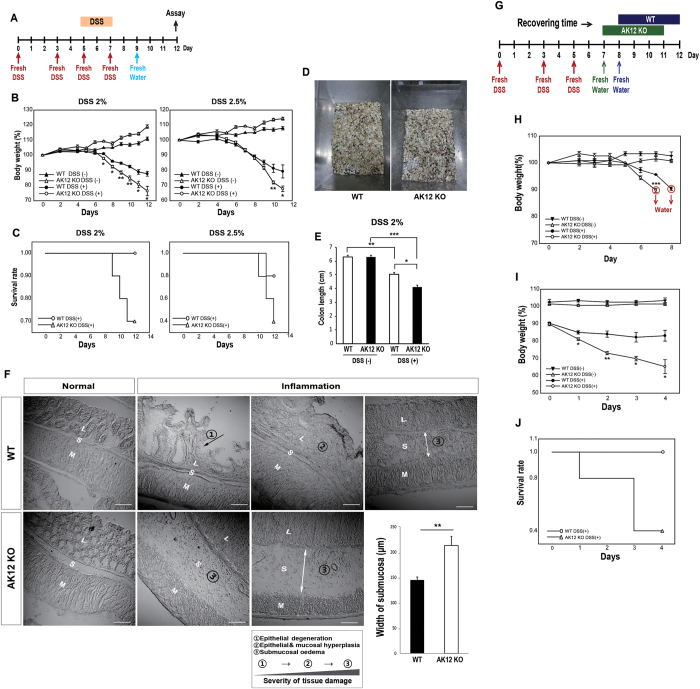
Protective role of AKAP12 during intestinal inflammation recovery.(A–F) WT and AKAP12 KO mice were given 2 or 2.5% DSS in their drinking water with control group (normal water) for 8 days and were then allowed to recover with normal drinking water for a further 4 days (n = 10 per group for DSS 2%, n = 5 per group for DSS 2.5% and n = 5 per group for controls). (A) Schedule of DSS ingestion to WT and AKAP12 KO mice. (B) Percentage of body weigh changes in WT and AKAP12 KO mice after given 2 or 2.5% DSS in water. (C) Proportion of survived mouse to total mouse in each groups were recorded at each days. (D) Picture of blood stools in cage of DSS induced WT and AKAP12 KO mice were taken. (E) Colon lengths were recorded by using ruler on day 12 (n = 5 or 4 for WT or AKAP12KO, respectively). (F) Tissue states were marked in images and numbered with order of tissue damage. Width of submucosa in image was measured by ruler and then the value was converted to real value by using scale (n = 5 per group). Bars: 100 μm. (G–J) WT and AKAP12 KO mice were given normal water for further 4 days after given 2% DSS until body weight of each group decreased to 90% compared to initial body weight or after given normal water (n = 5 per group for DSS 2% and n = 5 per group for controls). (G) Schedule for comparing the recovering ability of WT and AKAP12 KO mice directly. AKAP12 KO mice were given 2% DSS for 7 days and WT mice for 8 days and then, changed DSS water to normal water. (H) Body weights of WT and AKAP12 KO were decreased to 90% at 8 day and 7 day, respectively (red circle). (I) Body weight changes of WT and AKAP12 KO mice in recovering period were shown. (J) Proportion of survived mouse to total mouse in each groups were recorded at each days. L: lamina propria, S: submucosa, M: muscularis externa. All panels, P* < 0.05, P** < 0.01, P*** < 10−3. Error bars, s.e.m.